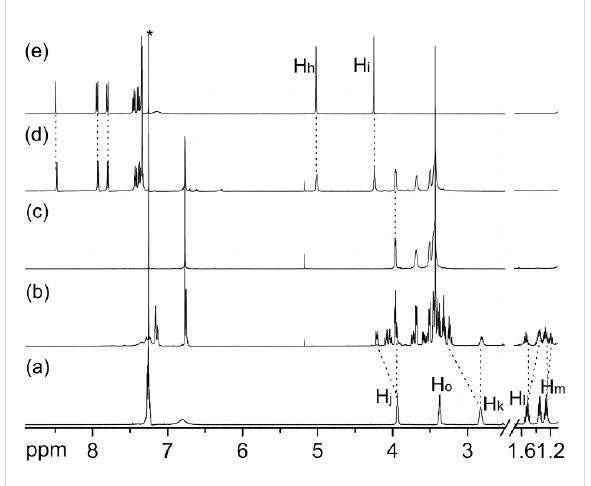
Figure 4: 1 H NMR spectra (500 MHz, 298 K, CDCl 3 :CD 3 CN = 2:1, 10.0 mM) of ( a ) 6 -HoPF 6 , ( b ) mixture of 6 -HoPF 6 and ( C7 +KPF 6 ), ( c ) ( C7 +KPF 6 ), ( d ) mixture of 5 -HoPF 6 and ( C7 +KPF 6 ), ( e ) 5 -HoPF 6 . Asterisk =